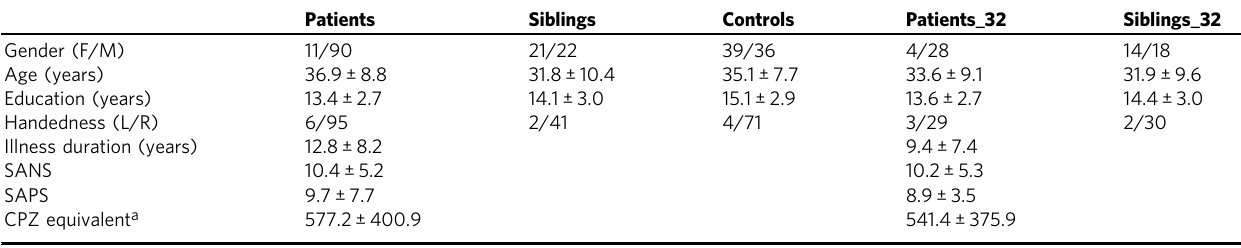
Table 4 Group average statistics (±SD) of patients, their siblings, controls, Patients_32, and